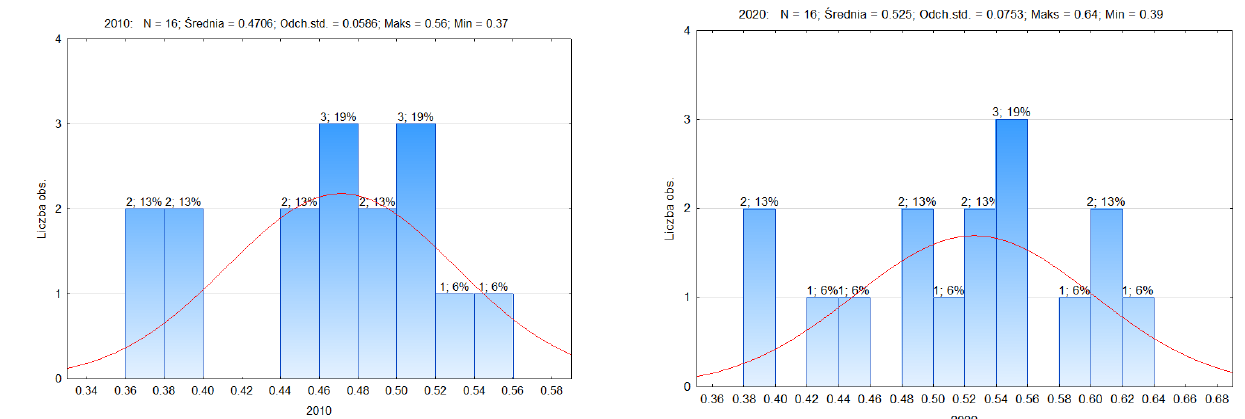
Figure 2. Distribution diagram showing the synthetic measure of the quality of life in voivodships in Poland in 2010 and 2020. Source: own study based on the BDL CSO data.